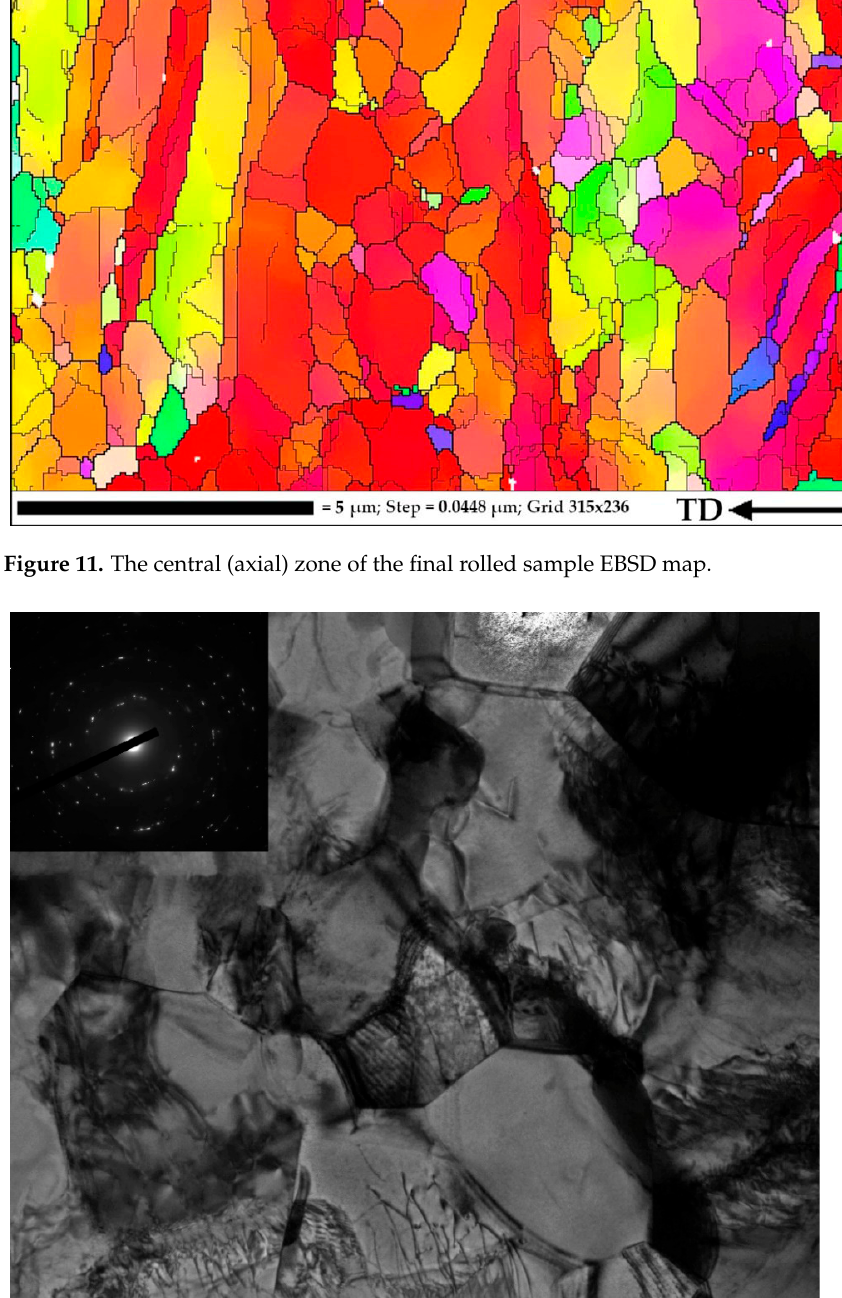
Figure 12. TEM-characterization of final sample peripheral structure.